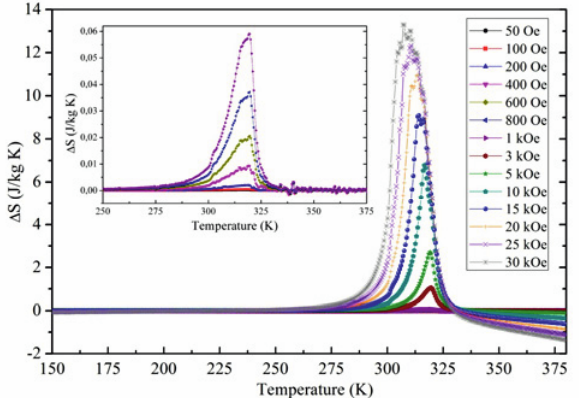
Figure 5. Differential scanning calorimetry scans. Ms, Mf and As, Af denote start and finish temperatures of the direct and reverse martensitic transformations, respectively. T C – the Curie temperature of austenite.